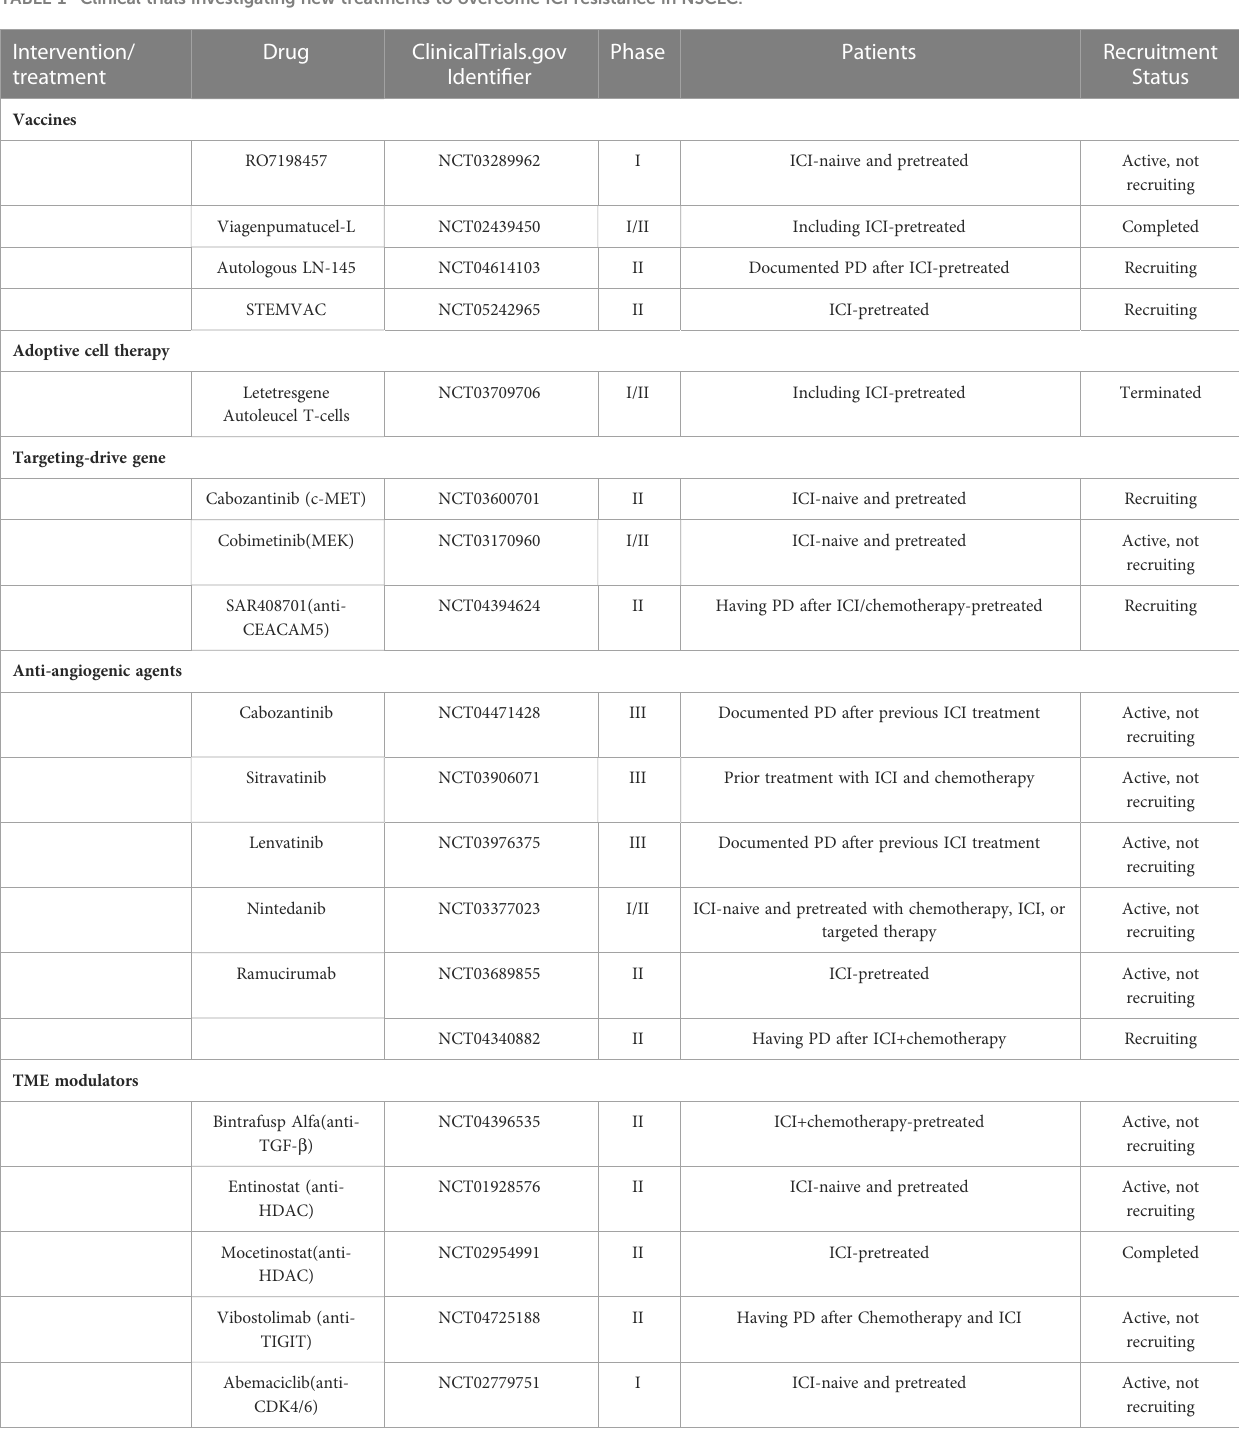
TABLE 1 Clinical trials investigating new treatments to overcome ICI resistance in